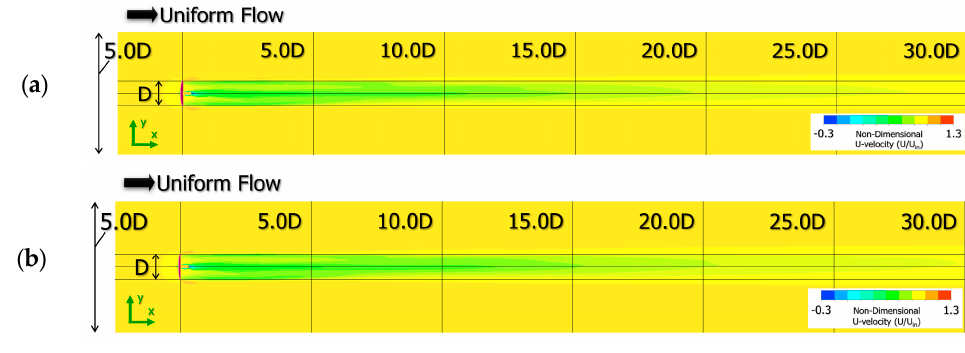
Figure A2. Spatial distribution of U-velocity for the time-averaged flow field in the y–z plane (front view) at x = 5.0 D: ( a ) 32.5 D (x) × 5.0 D (y) × 3.5 D (z), ( b ) 32.5 D (x) × 5.0 D (y) × 10.0 D (z), and ( c )